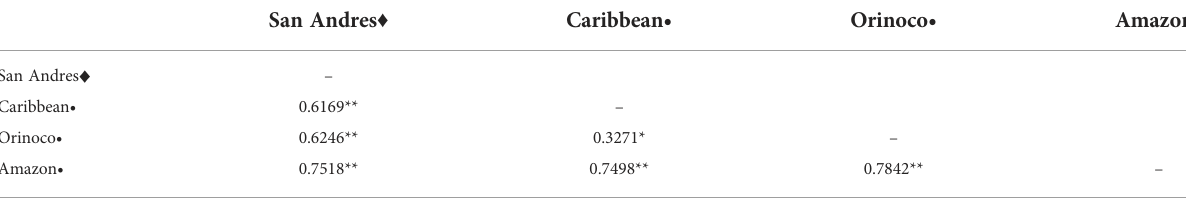
TABLE 2 Pairwise F ST estimated among biogeographical populations of the mud turtle ( Kinosternon scorpioides ) dsitributed on the insular ( (cid:129) ) and continental ( ♦ ) areas from Colombia, using 383 SNPs matrix with <10% of missing data across 23 samples. San Andres ♦ Caribbean (cid:129) Orinoco (cid:129)